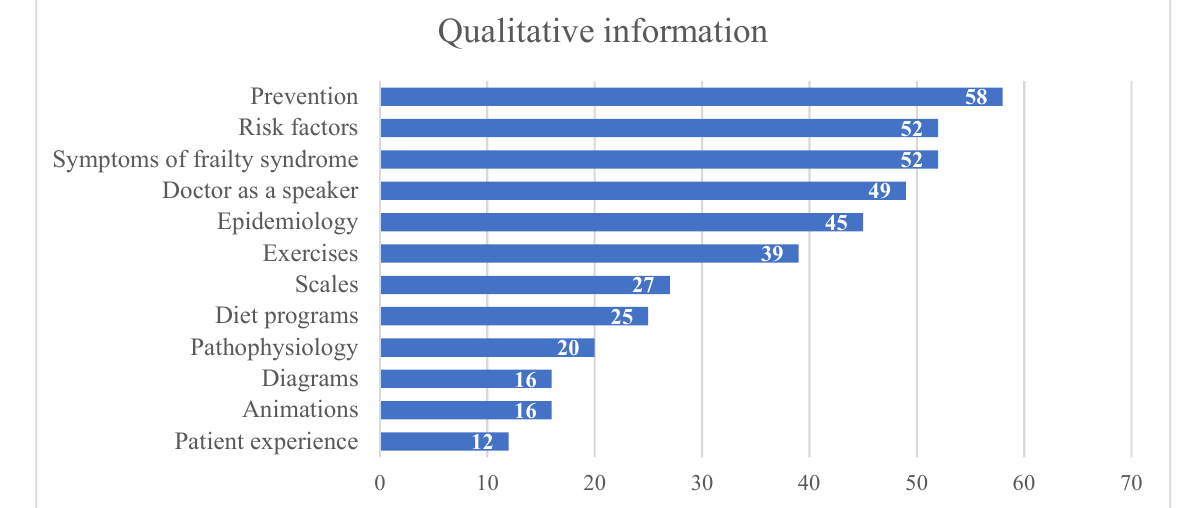
Figure 3. The summary of video content.